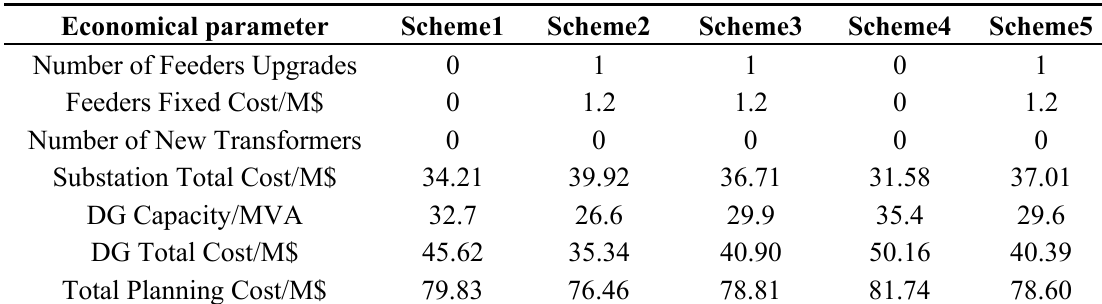
Table 9. Costs of five